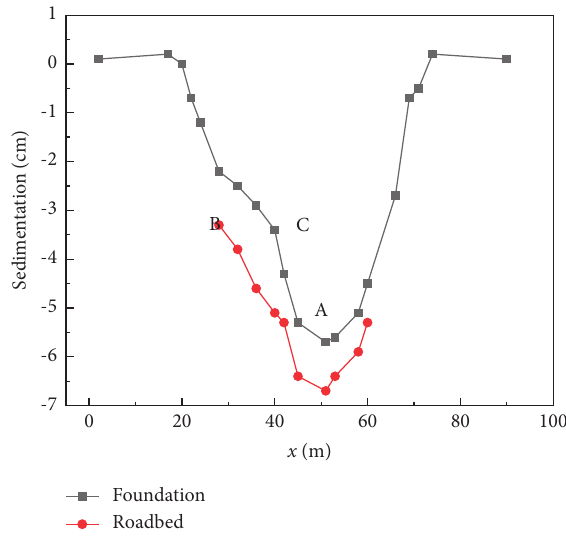
Figure 9: Settlement curve of foundation and subgrade.